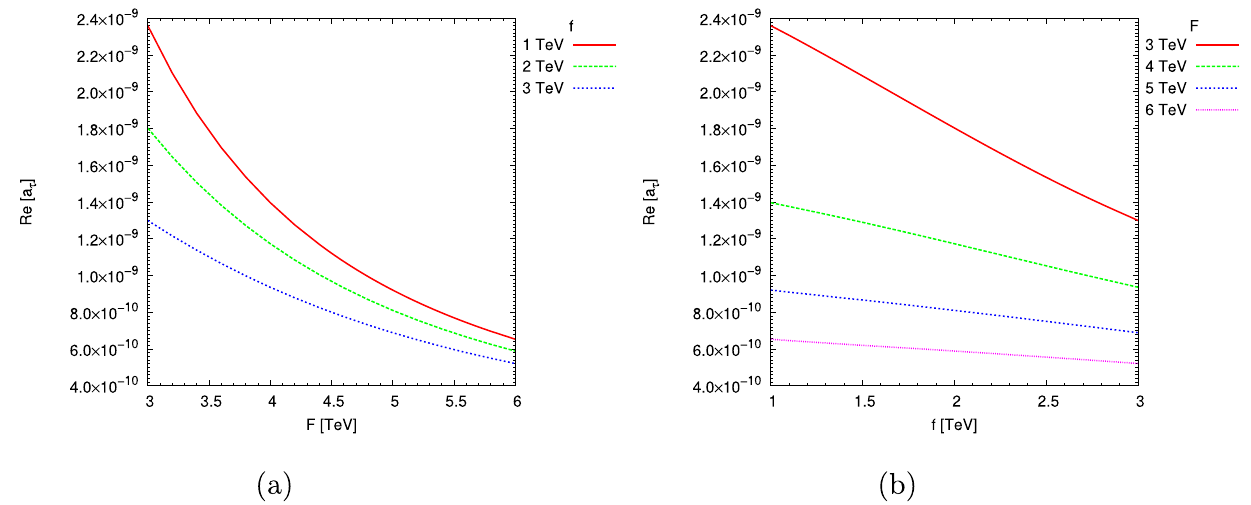
Fig. 5 a Total contribution to Re ( a τ ) for different values of the energy scale f . b Total contribution to Re ( a τ ) for different values of the energy scale F . The plots are obtained for specific fixed values of the f or F scale. The values provided in Table 3 are used for the remaining parameters of the model